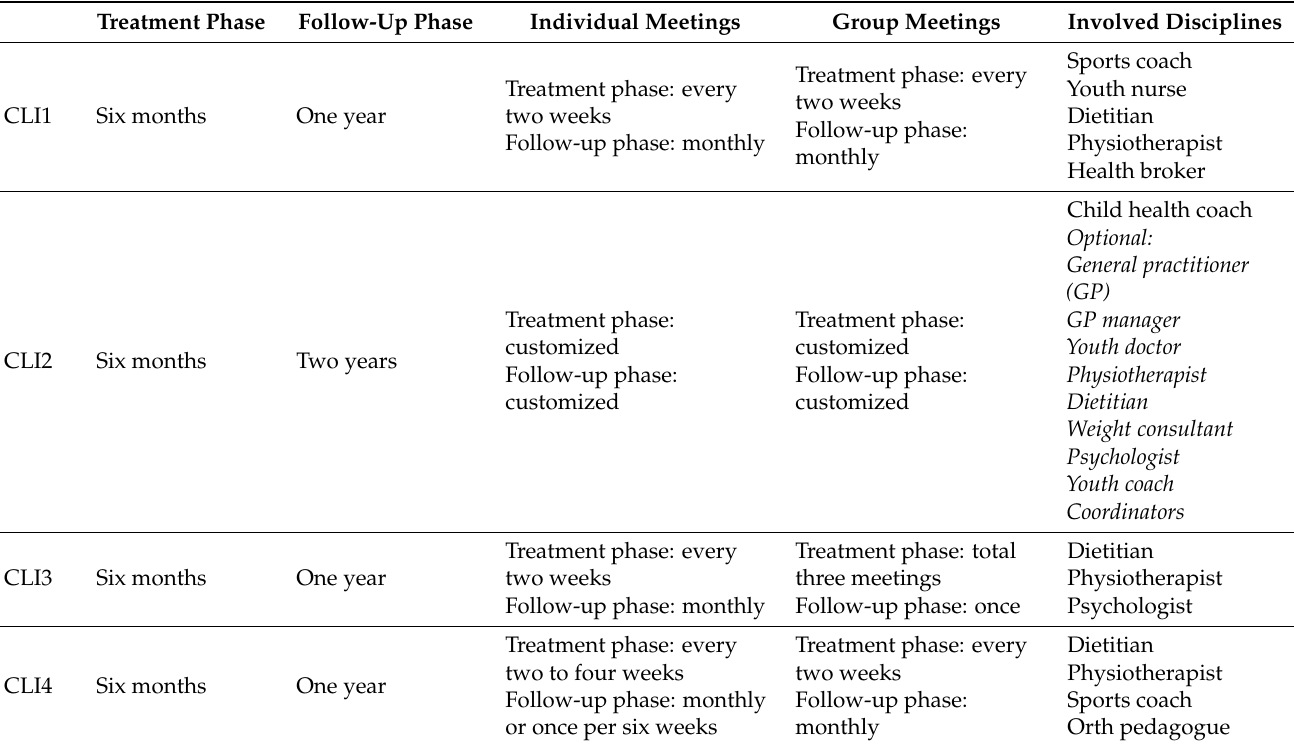
Table 1. Characteristics of the cases. An overview of the combined lifestyle interventions (CLIs) included and their